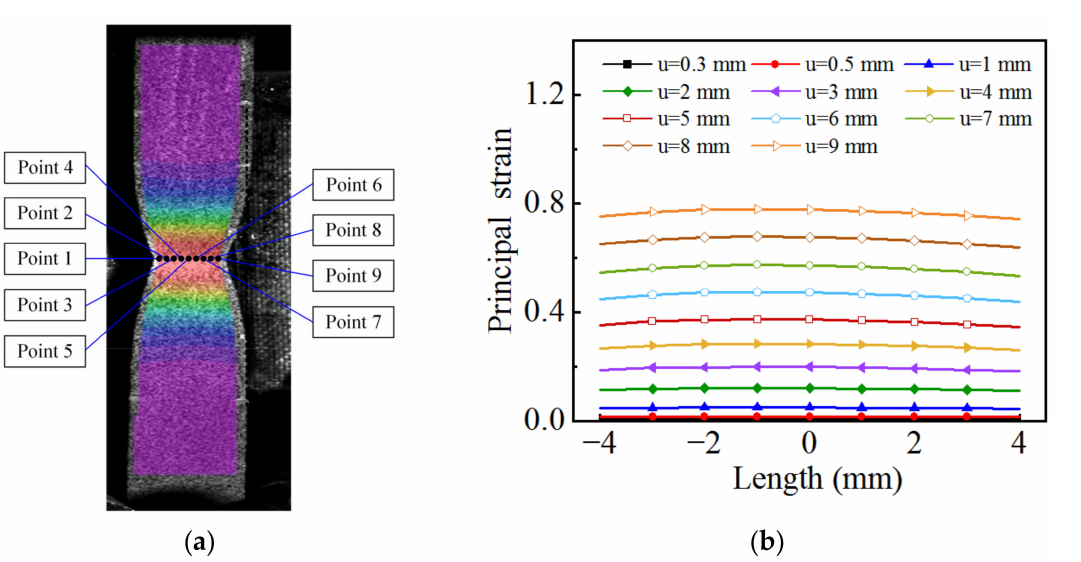
Figure 9. Principal strain distribution on the transverse line of the minimum cross-section: ( a ) location of measuring point; ( b ) principal strain